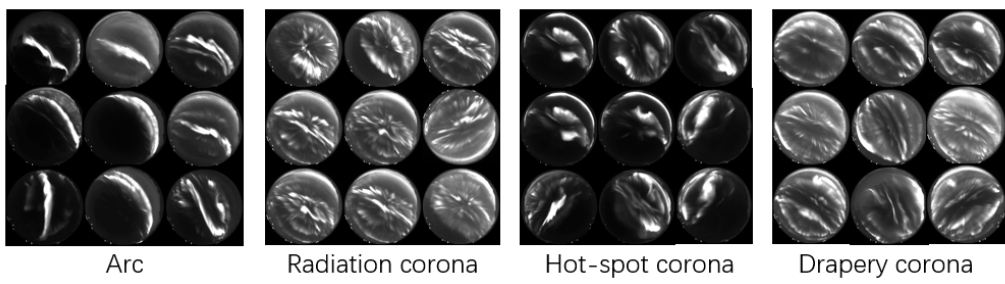
Figure 7. The four-class aurora image dataset.